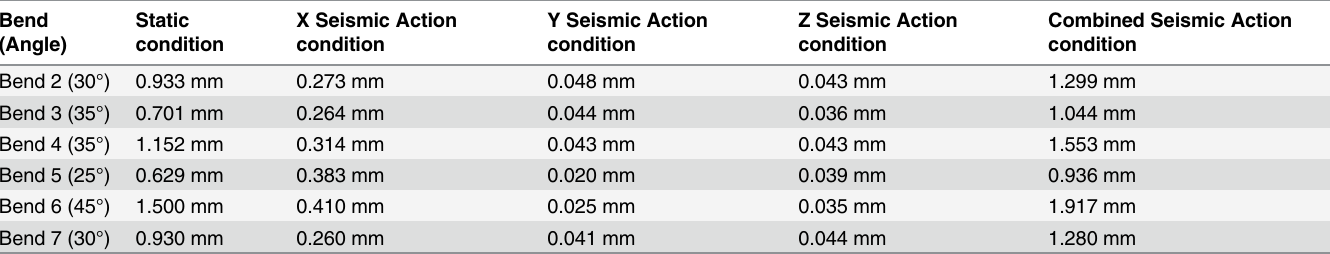
Table 11. Comparison of axial displacements of bends (25° – 45°) under different conditions.